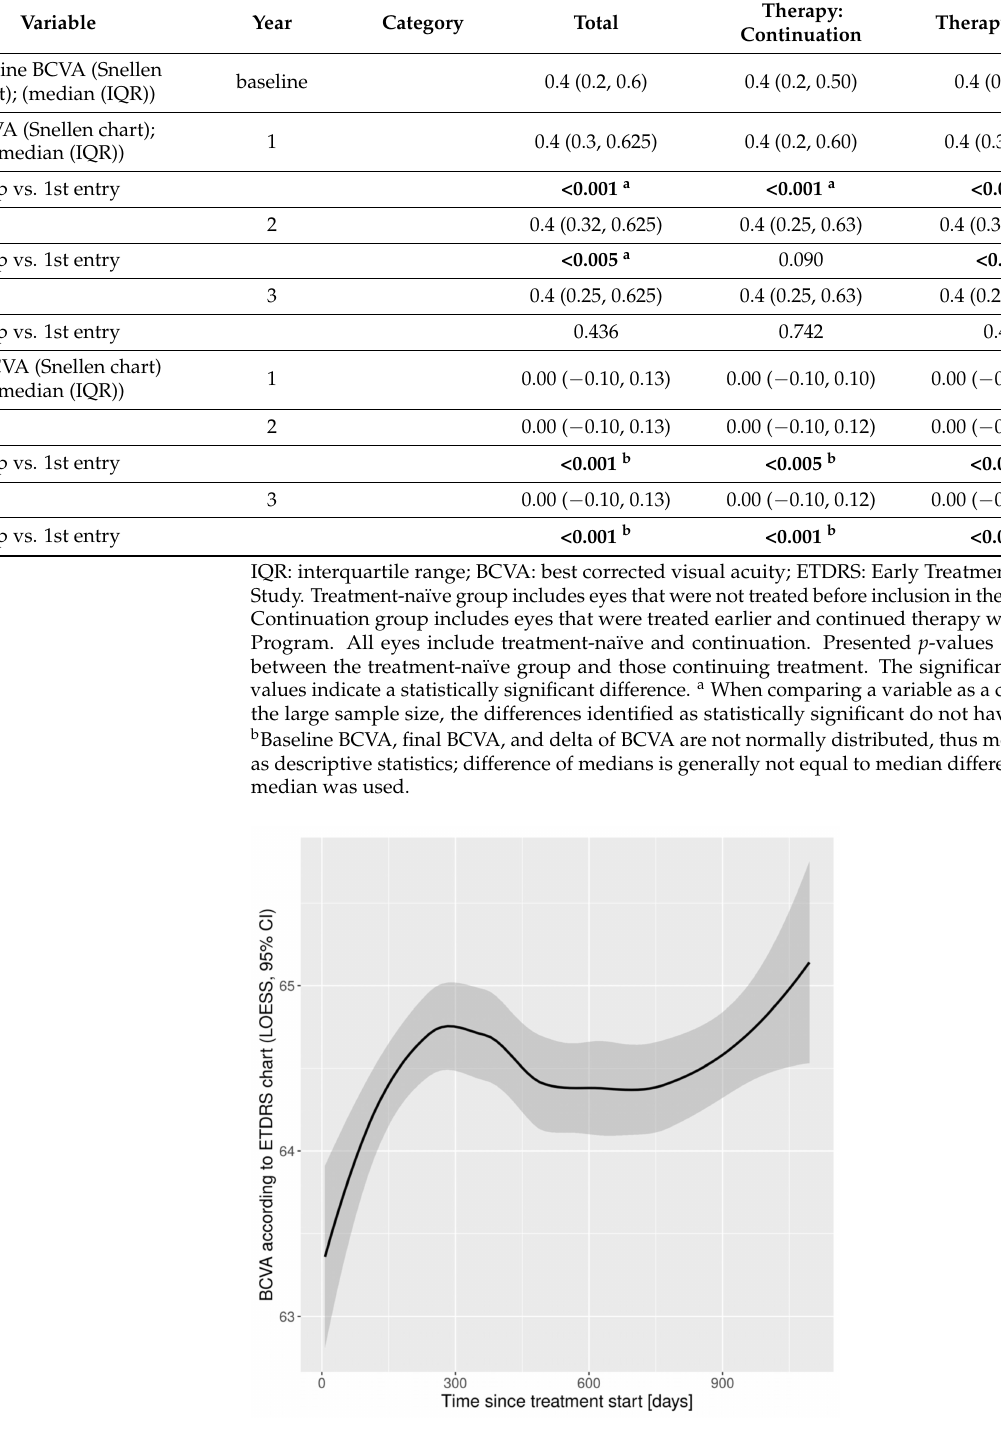
Figure 1. Functional outcomes: changes in Best Corrected Visual Acuity according to ETDRS chart in study population. BCVA, Best Corrected Visual Acuity; CI, Confidence Interval; ETDRS, Early Treatment Diabetic Retinopathy Study; LOESS, Locally Estimated Scatterplot